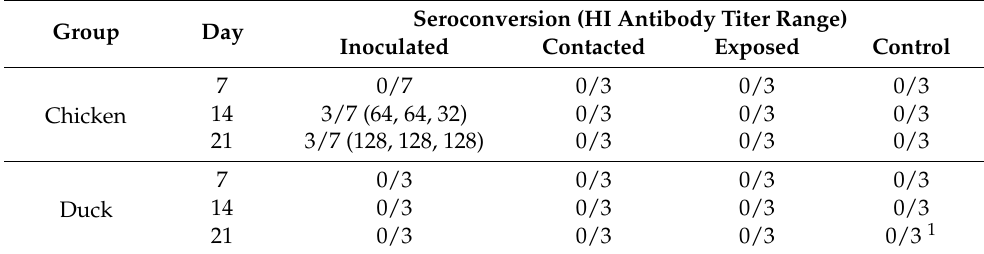
Table 2. Seroconversion of SPF chickens and ducks after H3N2 CIV infection.